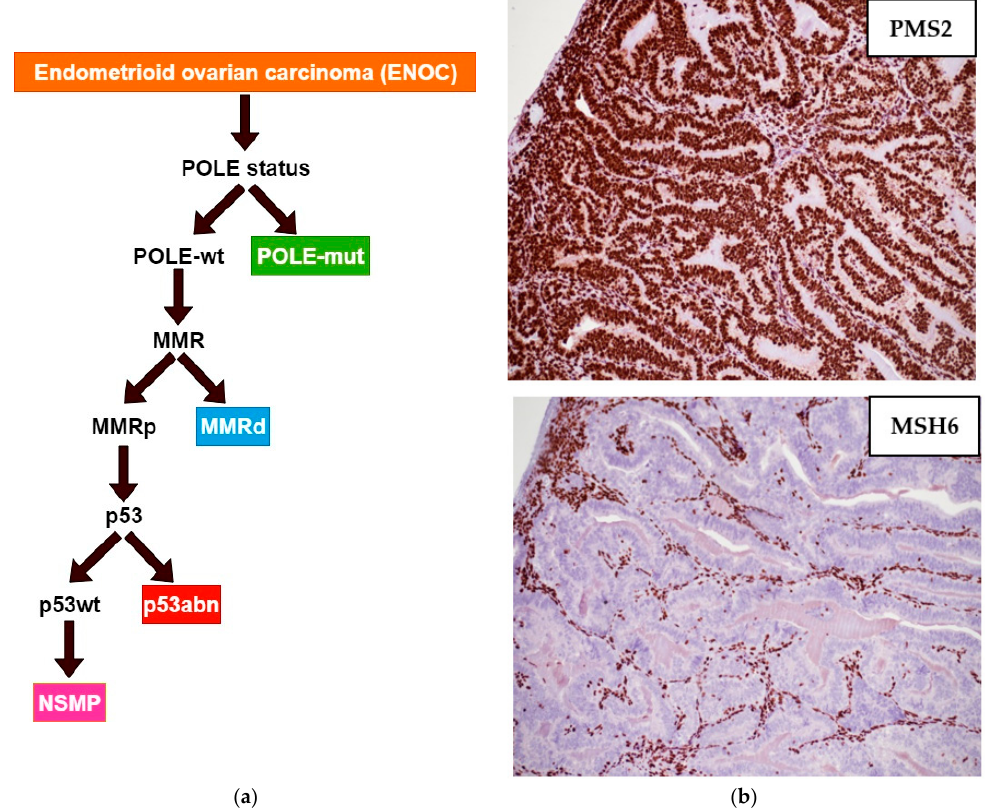
Figure 6. ( a ) Diagnostic algorithm to classify endometrioid ovarian carcinomas (left) (based on P. Krämer et al.). abn: abnormal; MMR: mismatch repair; MMRd: mismatch repair deficient; MMRp: mismatch repair proficient; mut: mutated; NSMP: no specific molecular profile; POLE: polymerase-epsilon; wt: wild-type. ( b ) MMRd endometrioid carcinoma low-grade, notable loss of MSH6 with intact PMS2 expression (x100). As internal control, tumor infiltrating lymphocytes and intertumoral stromal cells demonstrated intact MMR expression (x100).